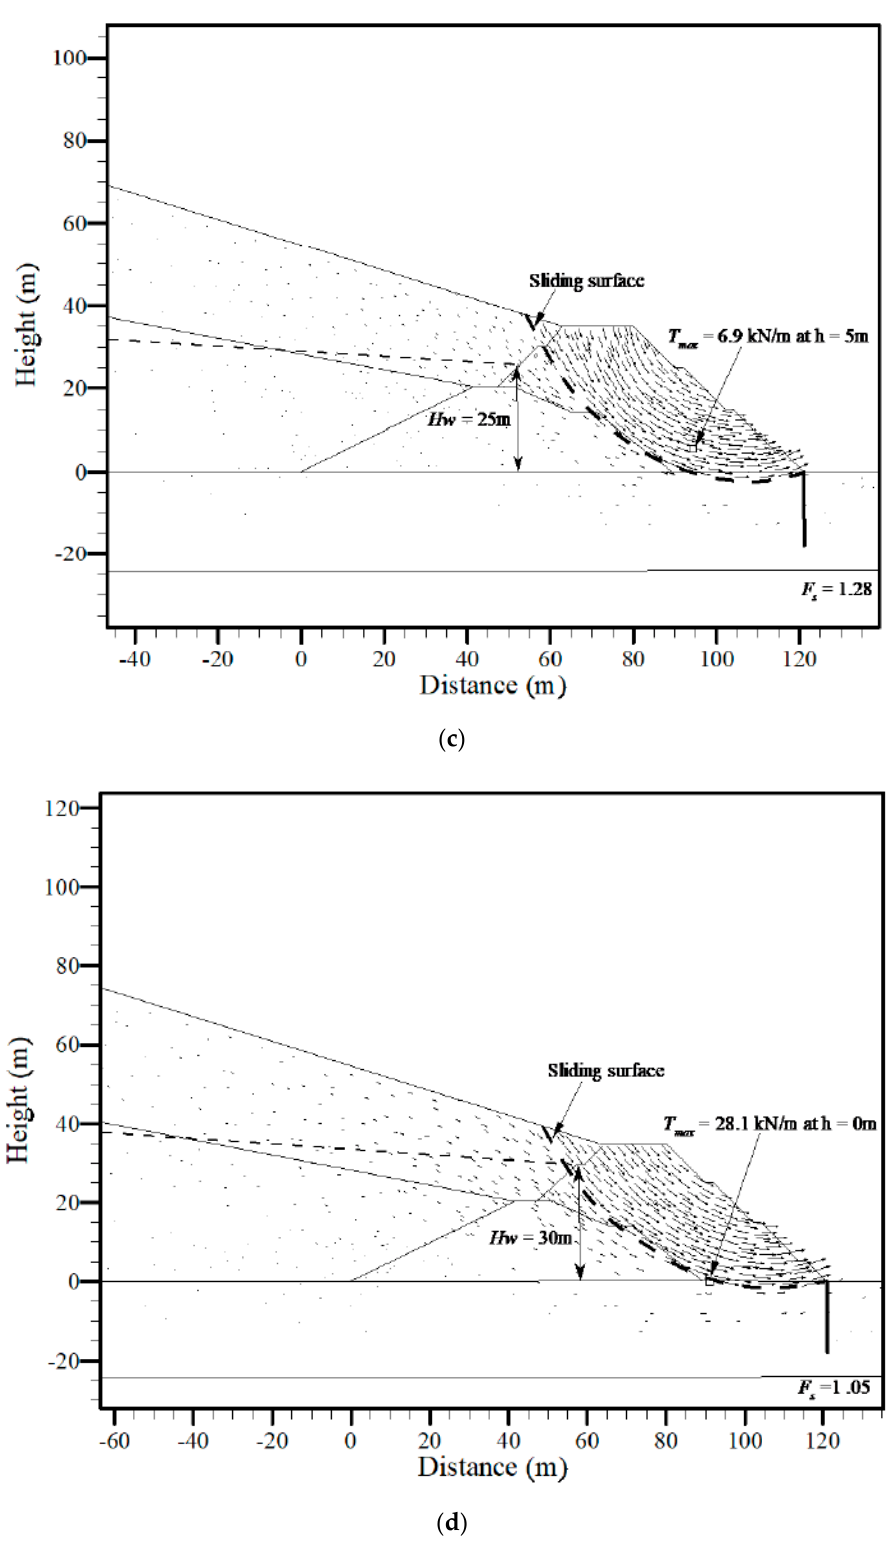
Figure 10. Effect of leachate level: ( a ) Leachate level I ( H w = 15 m), ( b ) Baseline ( H w = 20 m), ( c ) Leachate level II ( H w = 25 m), and ( d ) Leachate level III ( H w = 30 m).